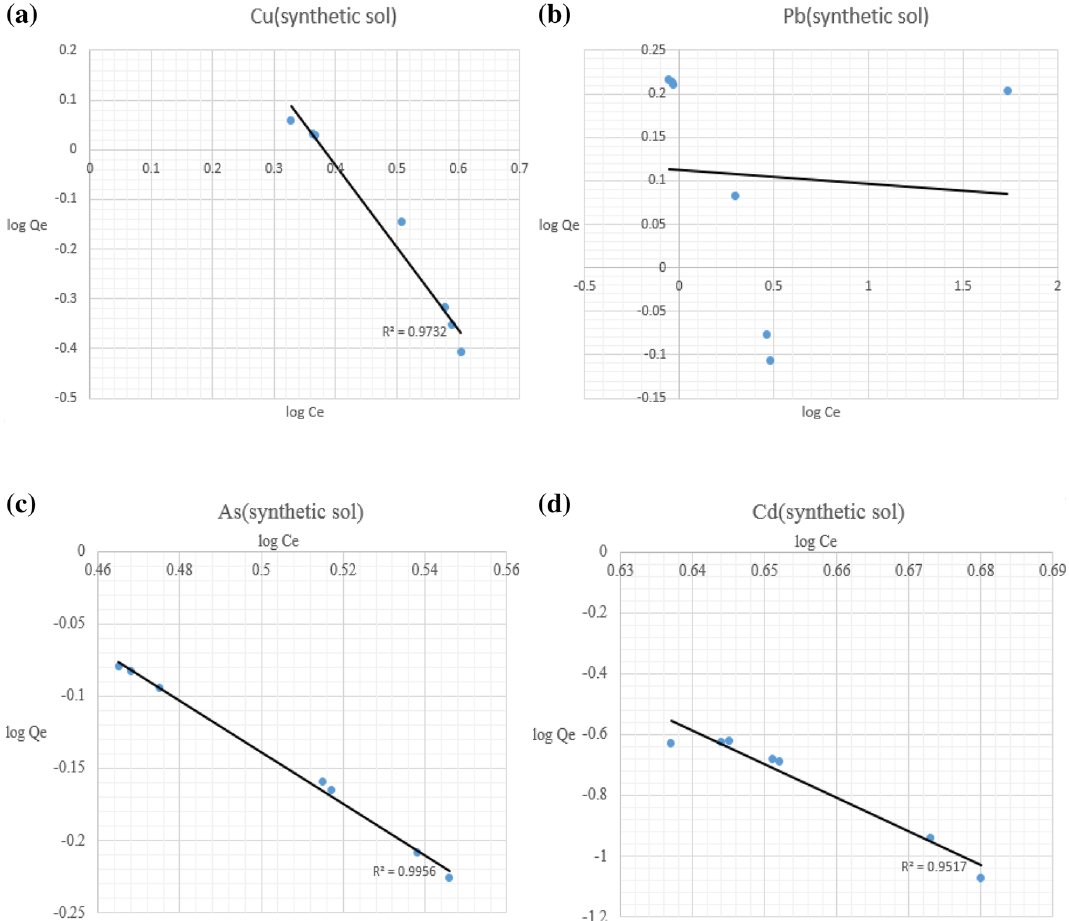
Fig. 8 Adsorption of heavy metals using Freundlich isotherm model in synthetic solution at different proportions of B:C bioadsorbent. a Cu, b Pb, c As, d